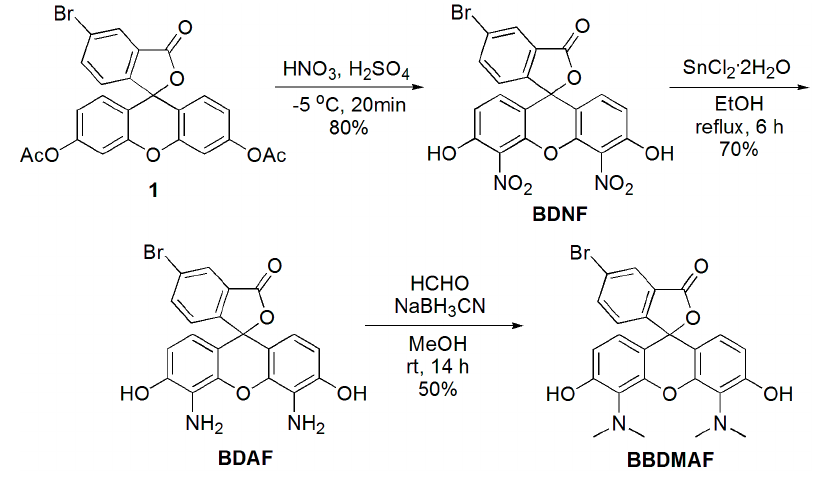
Figure 1. Fluorescein derivatives used in this